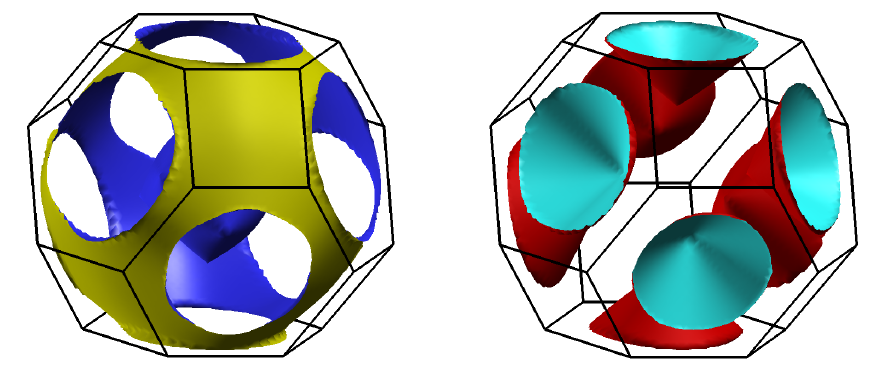
Figure 10: Calculated Fermi sheets of LaNiO netic R 3 c phase.